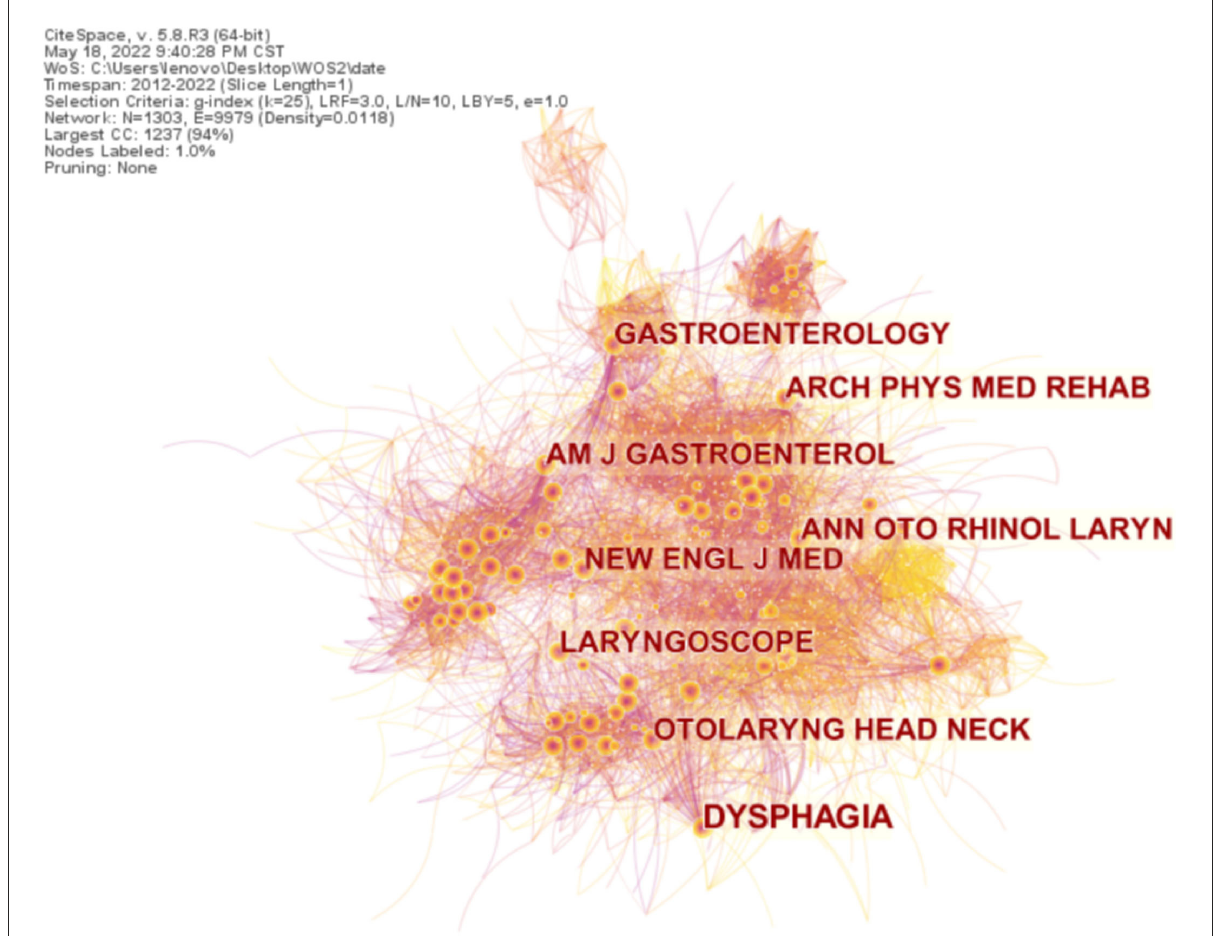
FIGURE3 Map of countries distribution and cooperative relations on dysphagia from 2012 to 2022. The larger the circle, the more often it is quoted. The shorter the distance between the two circles, the more the cooperation between the two journals.